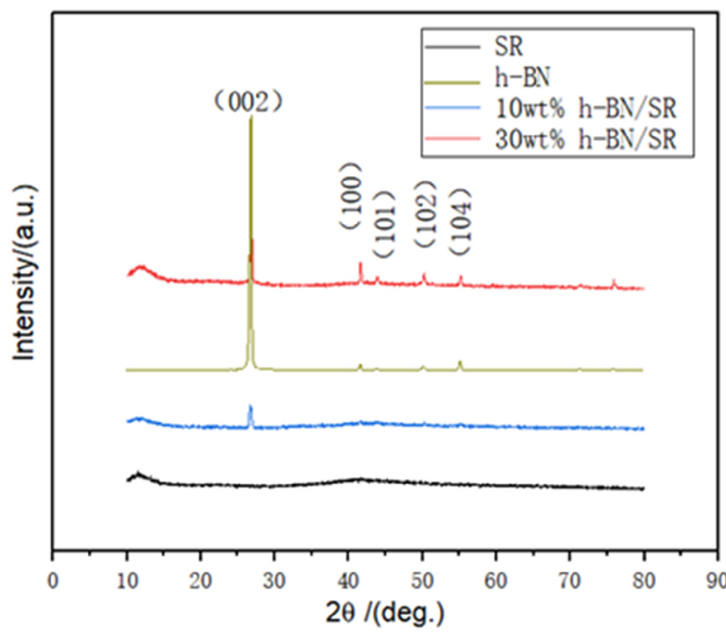
Figure 3. XRD spectra of h-BN, SR, and h-BN/SR composite.